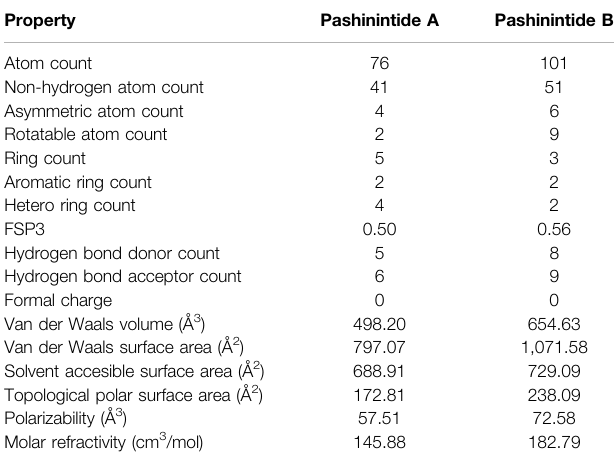
TABLE 2 | Geometrical and structural properties of the studied molecular systems. Property